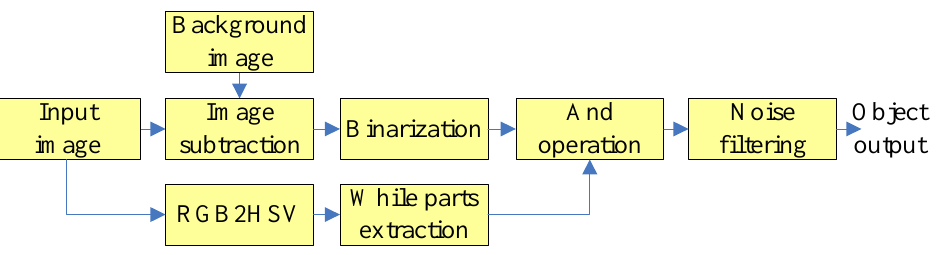
Figure 5. The flow chart of the image preprocessing of the risk area